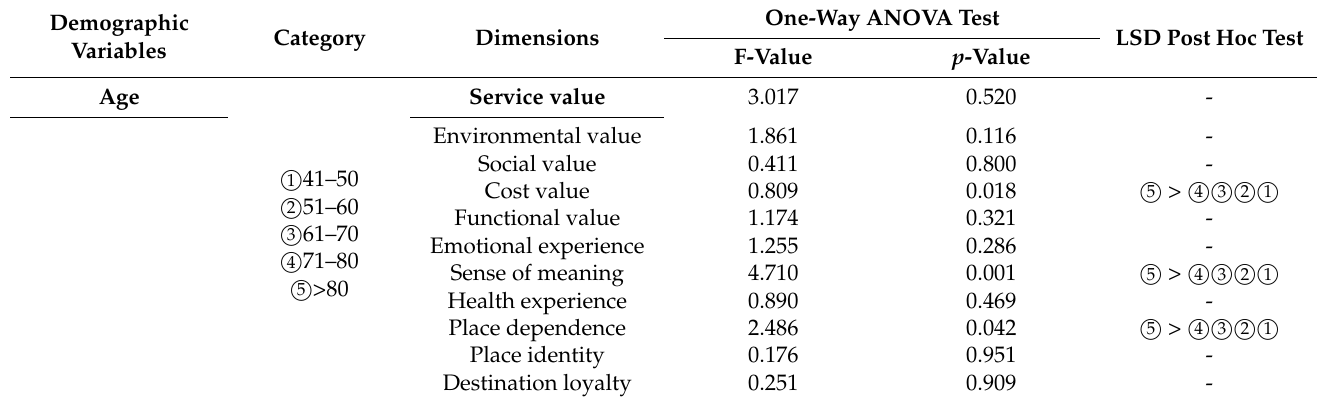
Table 3. Summary of the variability analysis for dimensions in the four